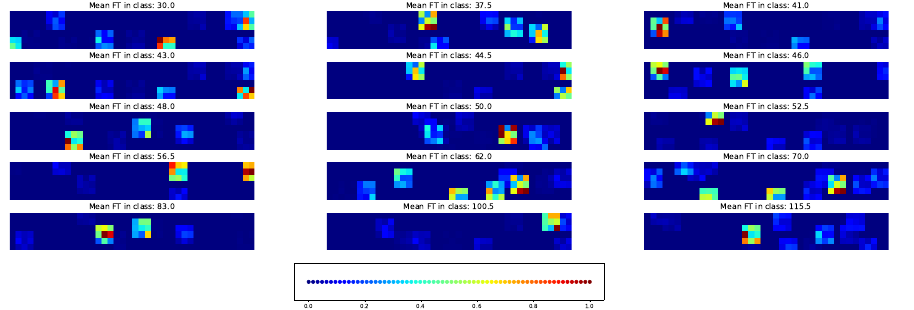
Figure 14. Example of the saliency map for individual acccessions in each time class and union SNP set. Figure S5 gives the same data with higher magnification.